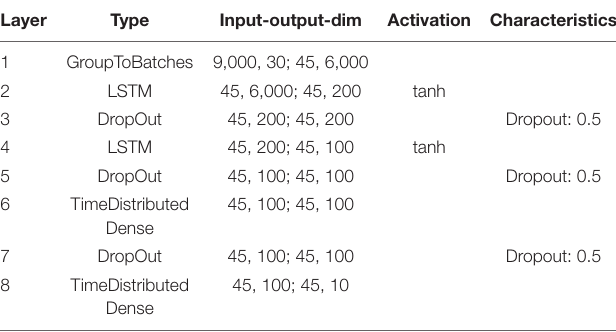
TABLE 3 | Exact parameters of the used LSTM network (FSDD data